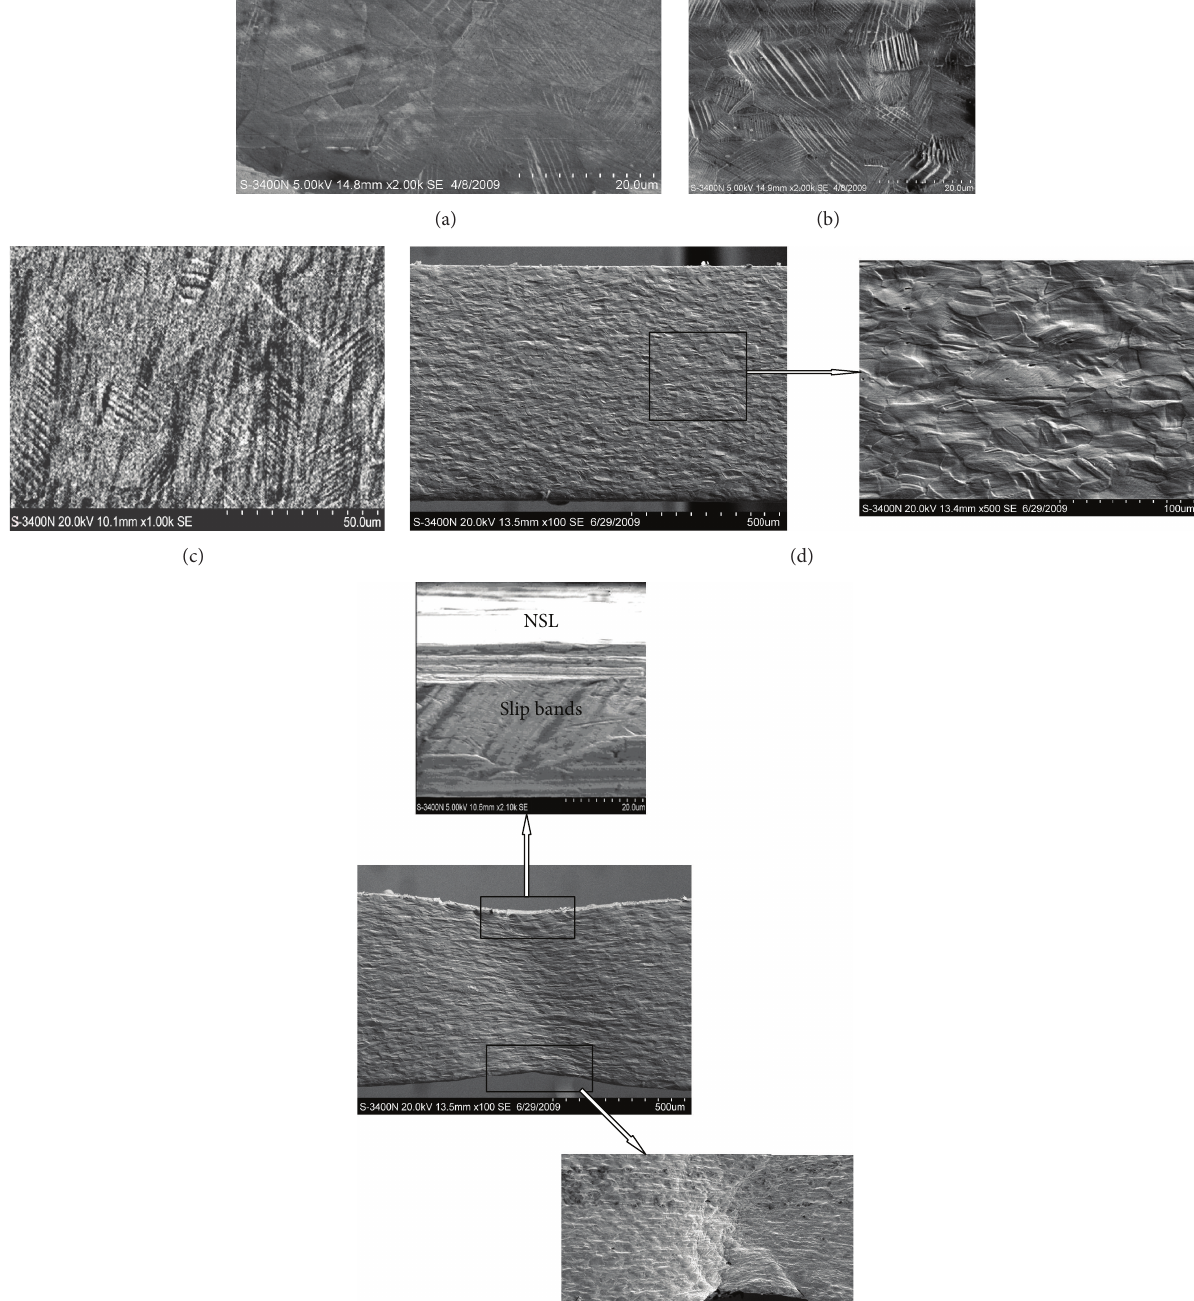
are difficult. As presented in Figure 8, the load-depth curve depicts a schematic of the stress-strain curve of the power law of the NSSL can be described using the power law equation: material as expressed in the Swift equation [24]: 𝐹 = 𝑘ℎ 2 , (1) 𝜎 = where 𝐹 is the load; 𝑘 is the curvature of the loading curve; and ℎ is the corresponding indentation depth. Figure 11